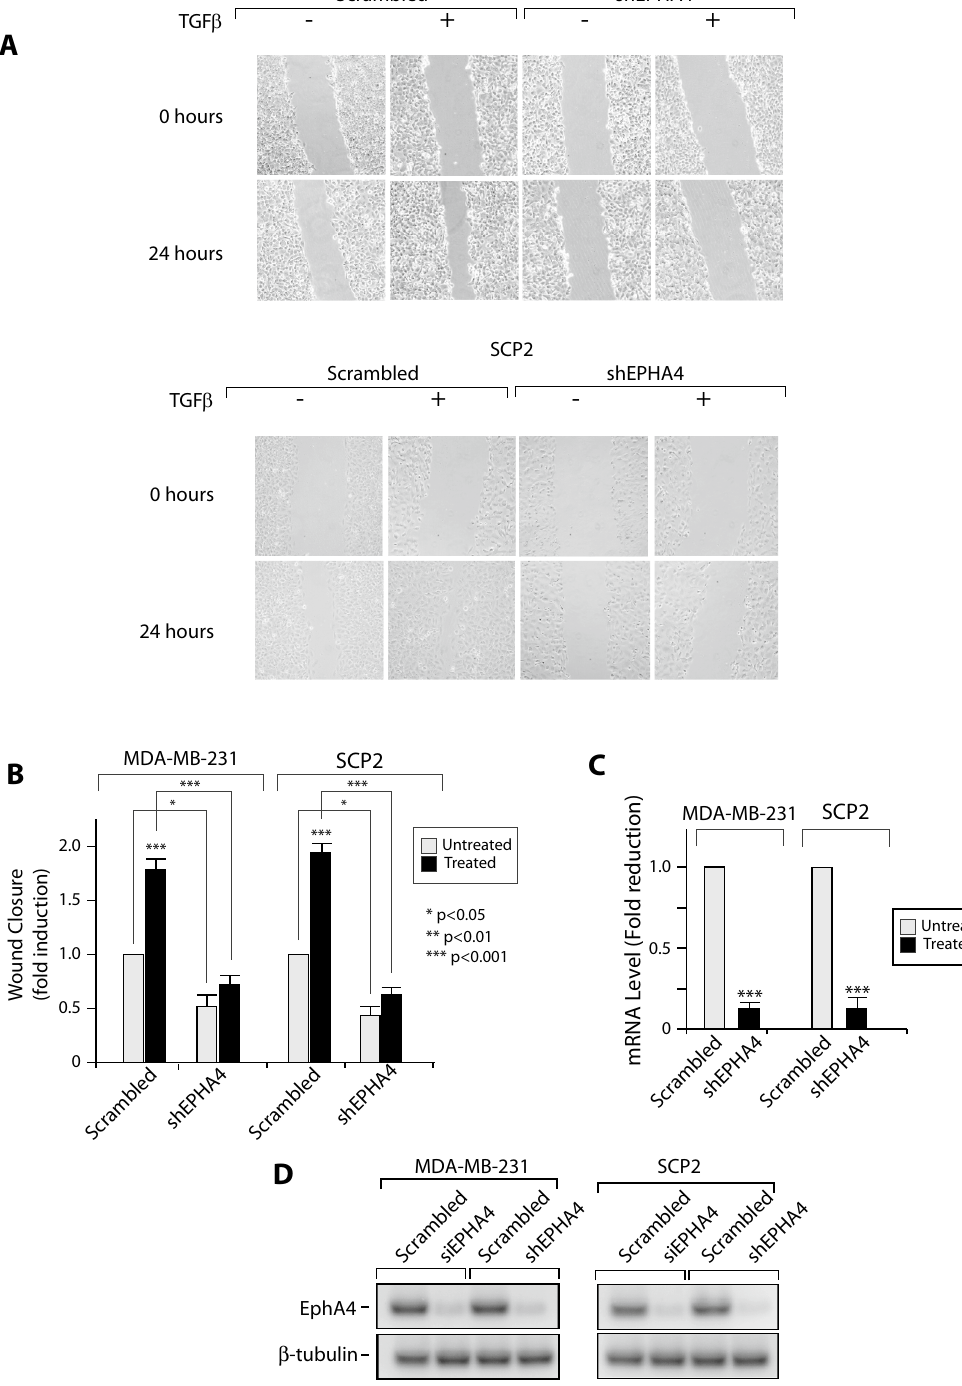
Figure 5. EPHA4 is required for TGFβ-mediated migration in human breast cancer cell lines. Stable MDA-MB-231 and SCP2 cell infected with a scrambled or EPHA4 specific shRNA were seeded to confluence in 6-well plates. Migration was measured following treatment with 0 or 5 ug/mL of TGFβ1 for 24 hours using a wound-healing migration